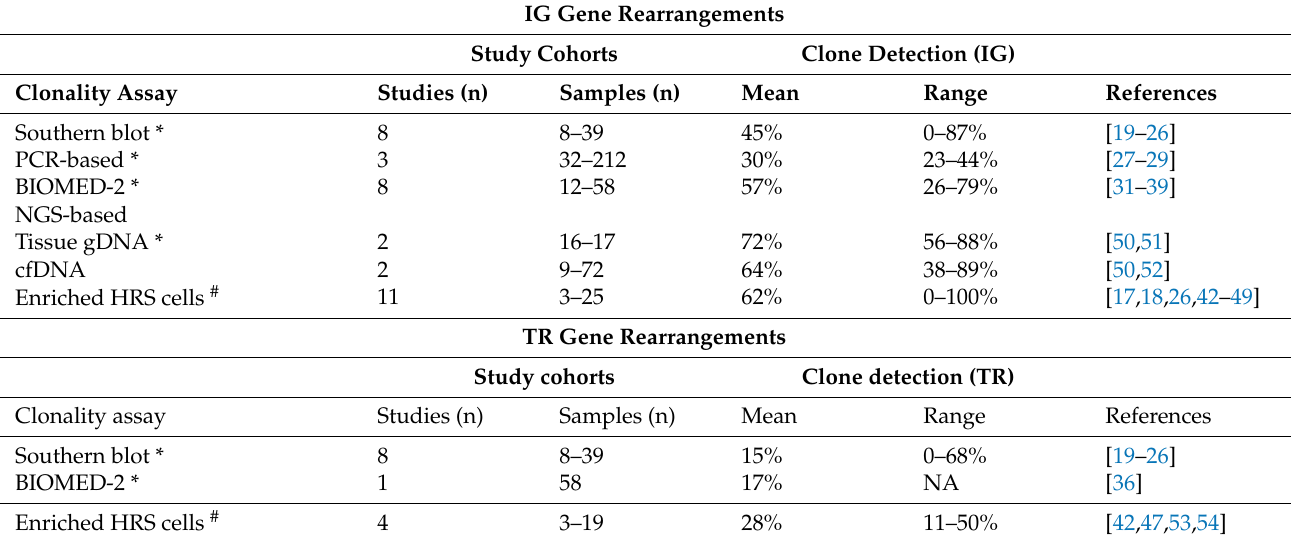
Table 1. Overview of clonality assessment in classical Hodgkin lymphoma by the analysis of IG and TR